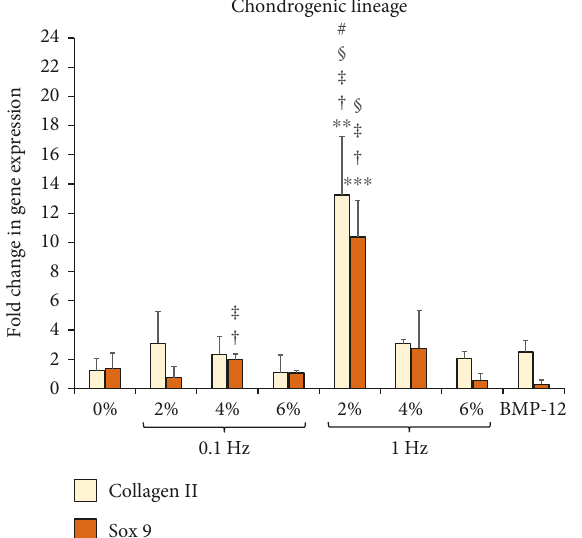
Figure 8: E ff ect of uniaxial tensile loading on chondrogenic gene expression of ASCs within 3D collagen sca ff olds. Gene expression pro fi les of ASCs encapsulated within collagen sca ff olds subjected to BMP-12 treatment or uniaxial loading at 0% (unloaded), 2%, 4%, and 6% strains at 0.1Hz and 1Hz loading frequencies. The graphs depict fold changes in various chondrogenic markers: collagen II and Sox 9. ∗∗ denotes p < 0 01 and ∗∗∗ corresponds to p < 0 001 . † represents a signi fi cant di ff erence between 2% and 4% groups while ‡ is the statistical di ff erence with respect to 6% group, both with a 95% con fi dence interval. # represents a signi fi cant di ff erence between 0.1Hz and 1Hz groups at the same magnitude of strain with p < 0 05 . § depicts signi fi cant di ff erence with respect to unloaded samples chemically stimulated with BMP-12 with p < 0 05 . Samples stimulated with 2% strain at 1Hz showed increased levels of both chondrogenic markers.